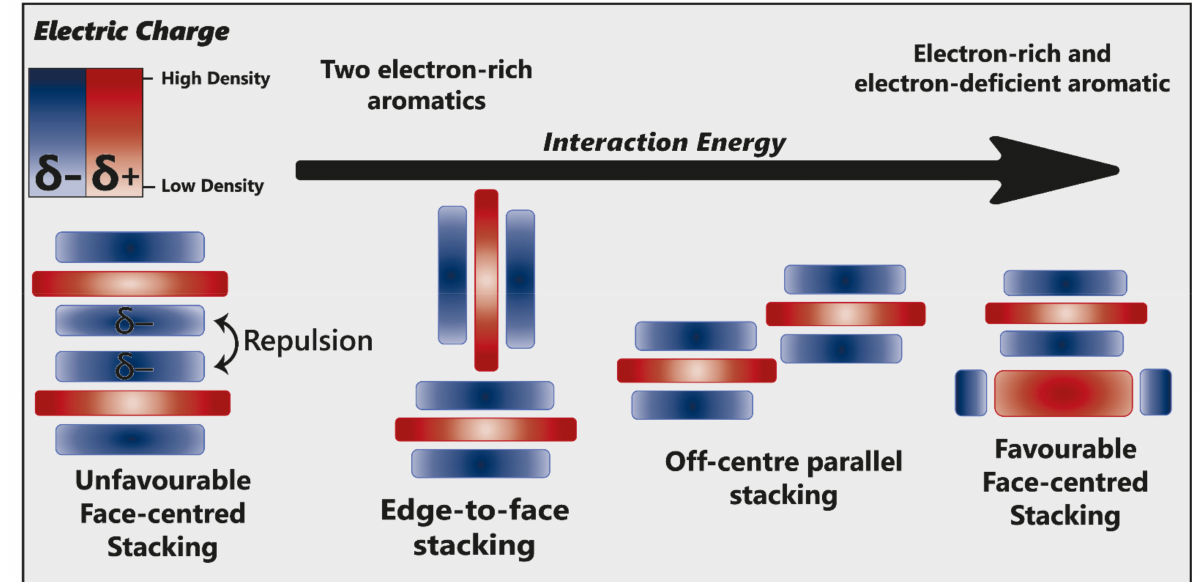
Figure 15. Alternative modes of stacking are shown, emphasising the locations of electrostatic attraction or repulsion. As the interaction energy increases, so too does complex stability. Adapted from